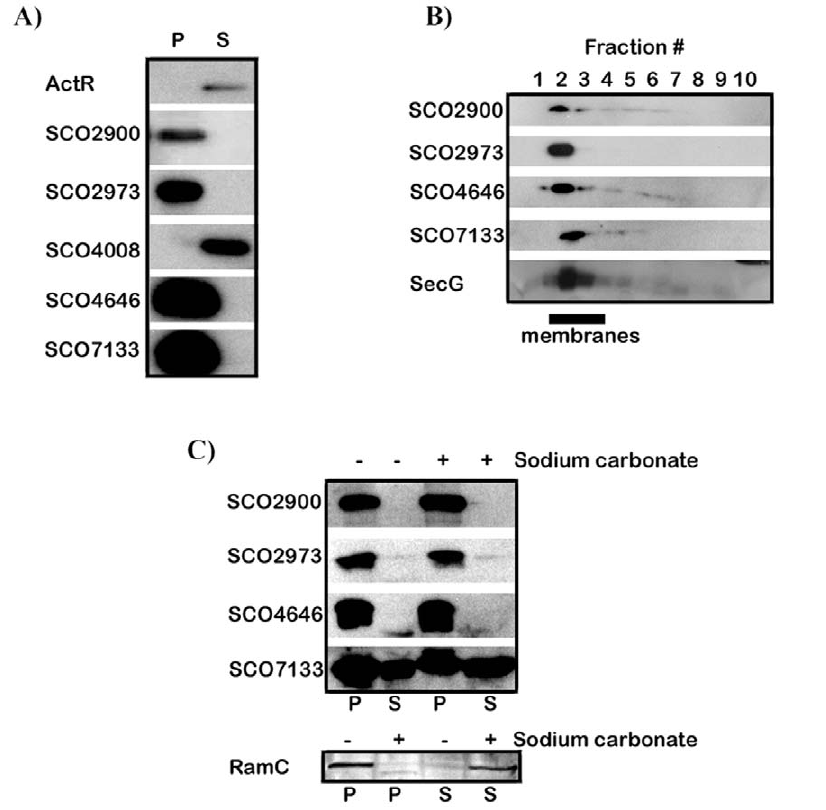
Figure 3. Membrane-association of five candidates. ( A ) Cells were fractionated into pellet (P) and supernatant (S) fractions and Western blot analysis directed against the FLAG epitope was used to determine the localization of the putative membrane proteins SCO2900, SCO2973, SCO4008, SCO4646 and SCO7133. ActR was used as a cytoplasmic control. ( B ) The pellets from (A) were subjected to sucrose gradient ultracentrifugation and 1 ml fractions were collected with fraction 1 corresponding to the highest density and fraction 10 the lowest. Fractions 2 to 4 (underlined) correspond to sedimentation profiles of known membrane proteins. ( C ) Carbonate extraction of TAMP proteins. Cell lysate was mixed with either sucrose ( 2 ) or carbonate ( + ) and separated into pellet (P) and supernatant (S) fractions. Fractions were subjected to Western blot analysis. The peripheral membrane protein RamC was used as a control.